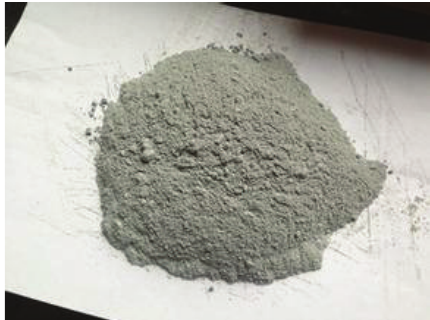
Figure 5: Silica